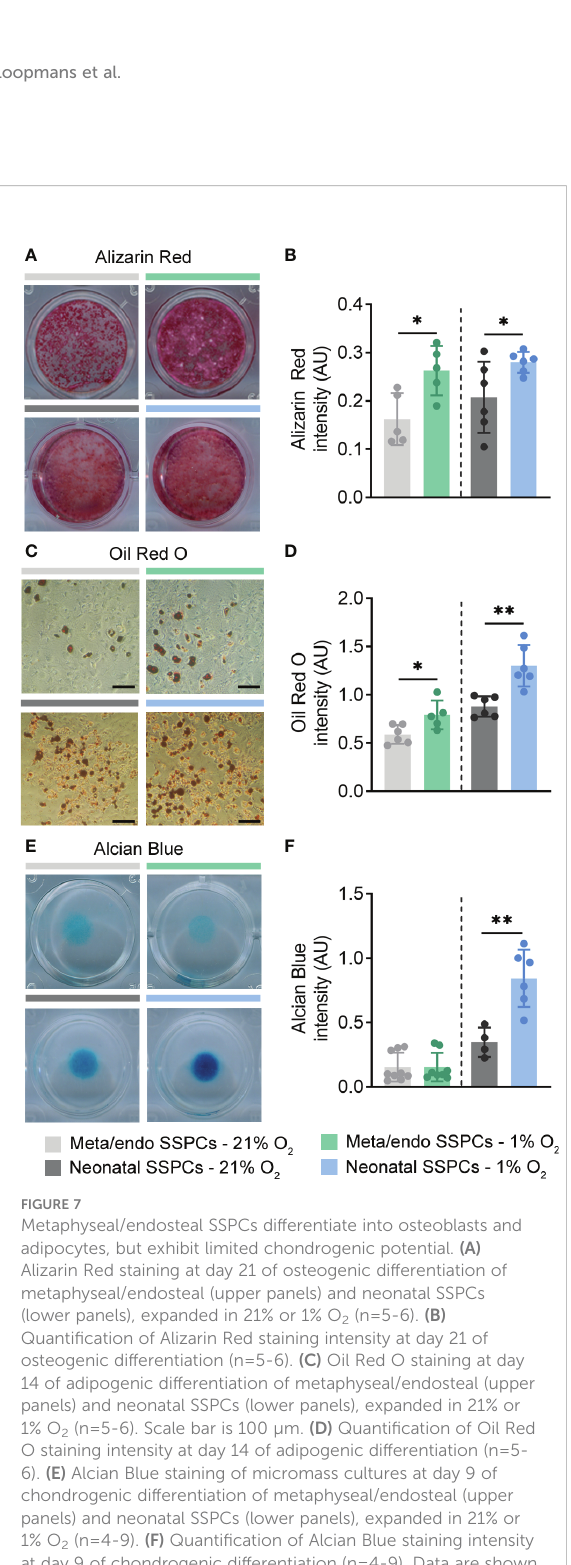
single- fl uorescent reporter models described above.